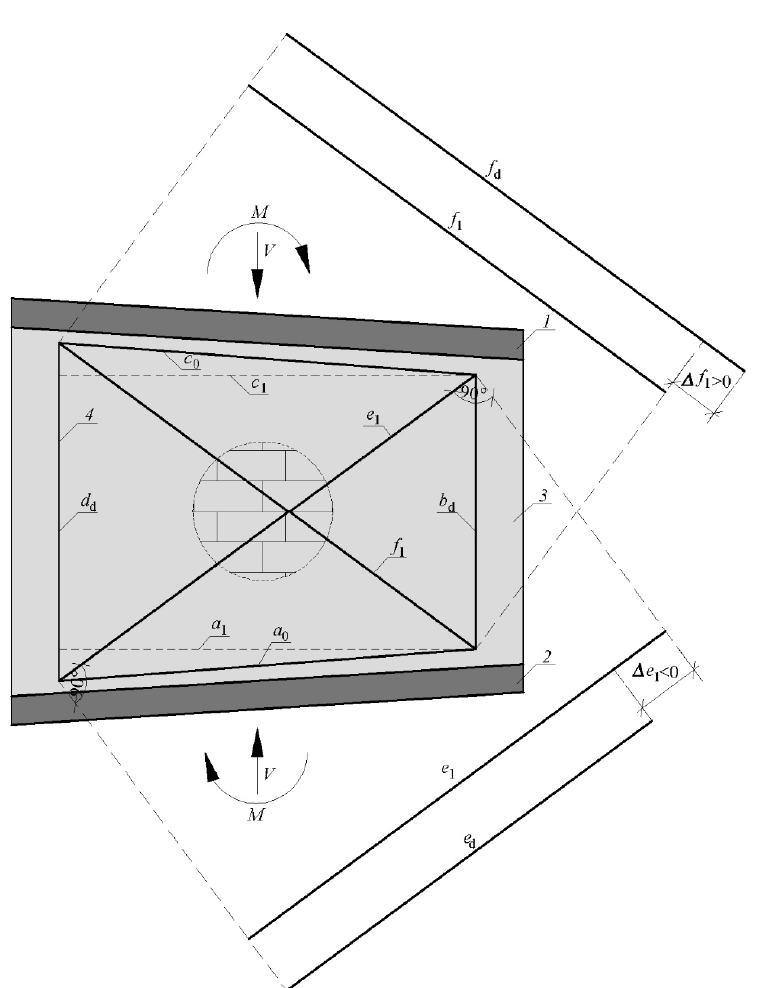
Figure 9. Deformation of measuring base resulting from flexural deformation; V —vertical force; M —in-plane bending moment; 1 —rigid diaphragm; 2 —concrete foundation; 3 —masonry wall made of AAC; 4 —measuring base before deformation; a 0 , c 0 —undeformed horizontal part of the frame system; e 1 , f 1 —deformed diagonal part of the frame system (result from flexural deformation).